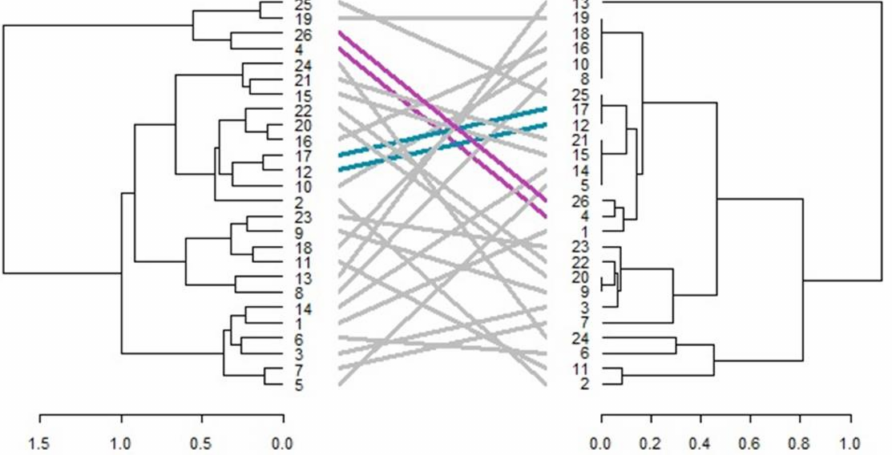
Figure 7. Tanglegram comparison of phenotypic and genotypic hierarchical clusters of 26 okra accessions based on 9 SSR markers and phenotypic data measured under drought-stressed conditions.